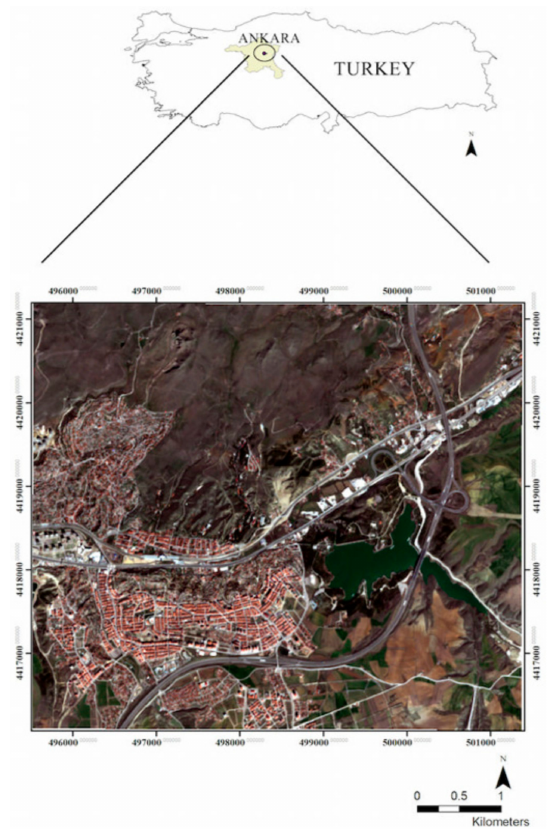
Figure 1. The location of the study area and an overview of the Sentinel-2 red–green–blue (RGB) image used in the study (upper left coordinates: 32 ◦ 56 (cid:48) 51.372” E, 39 ◦ 56 (cid:48) 27.108” N; lower right coordinates: 33 ◦ 0 (cid:48) 57.578” E, 39 ◦ 53 (cid:48) 41.689”